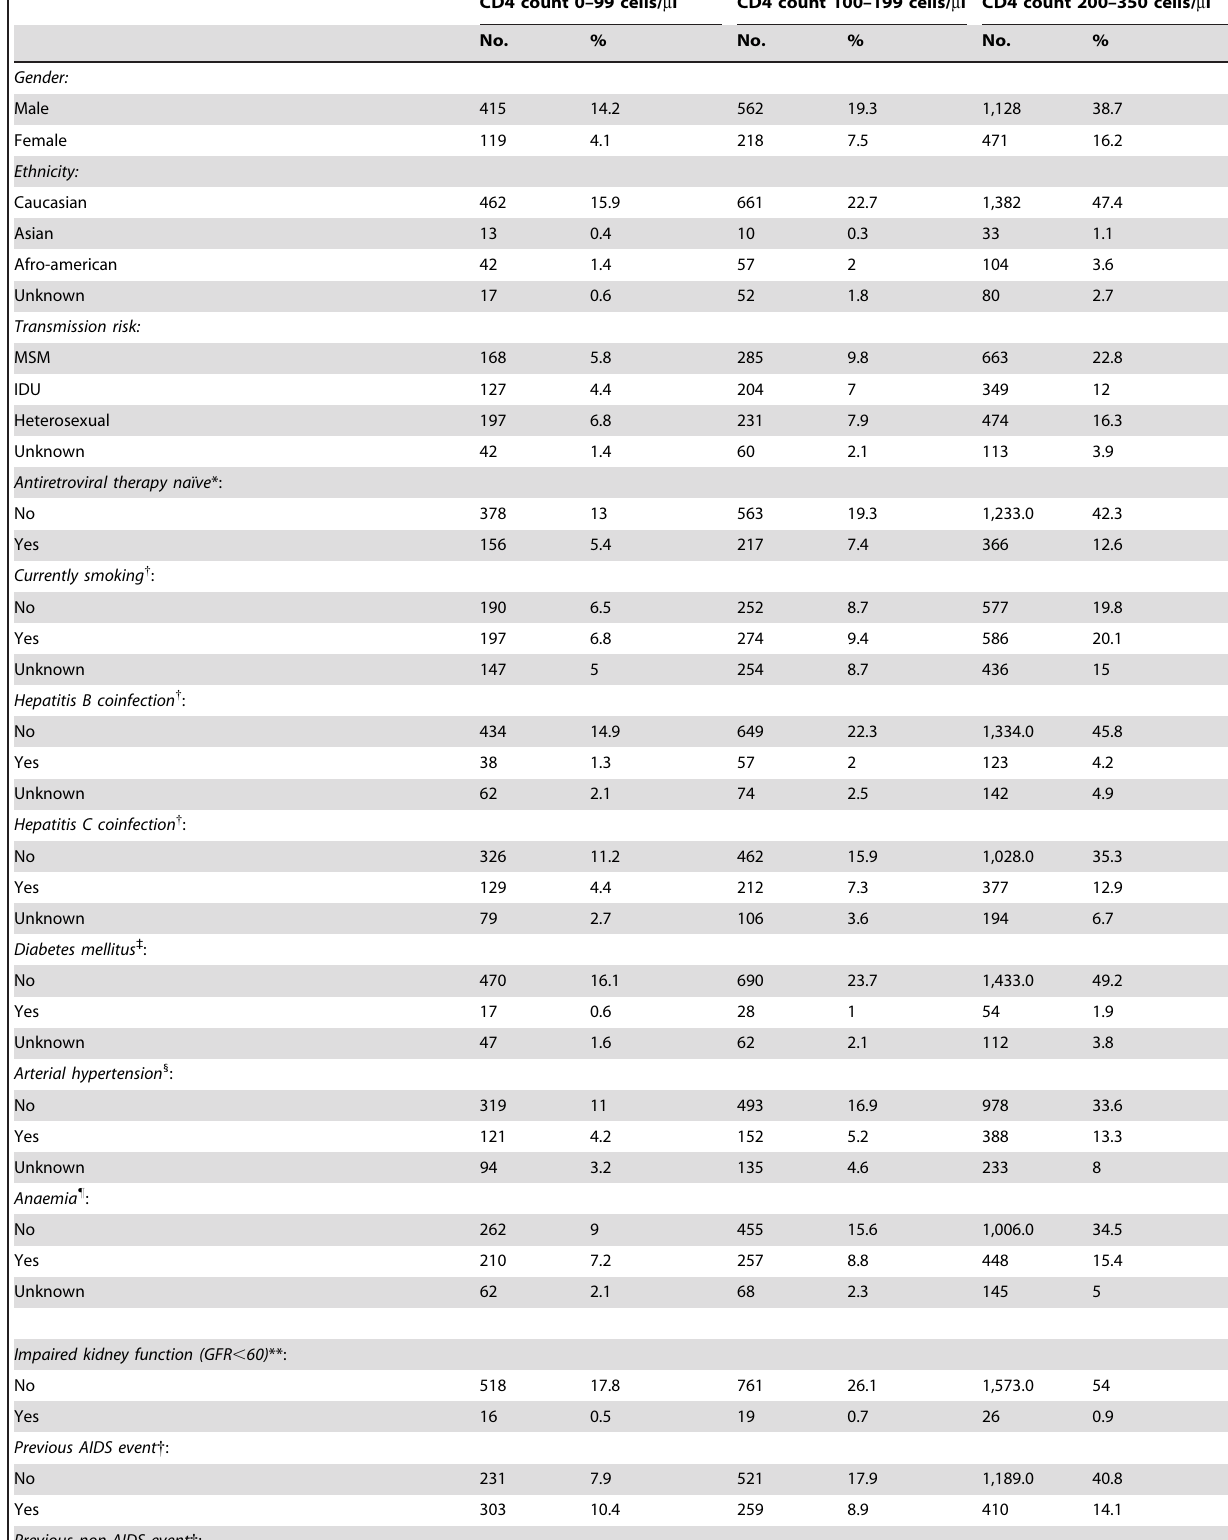
Table 1. Patient